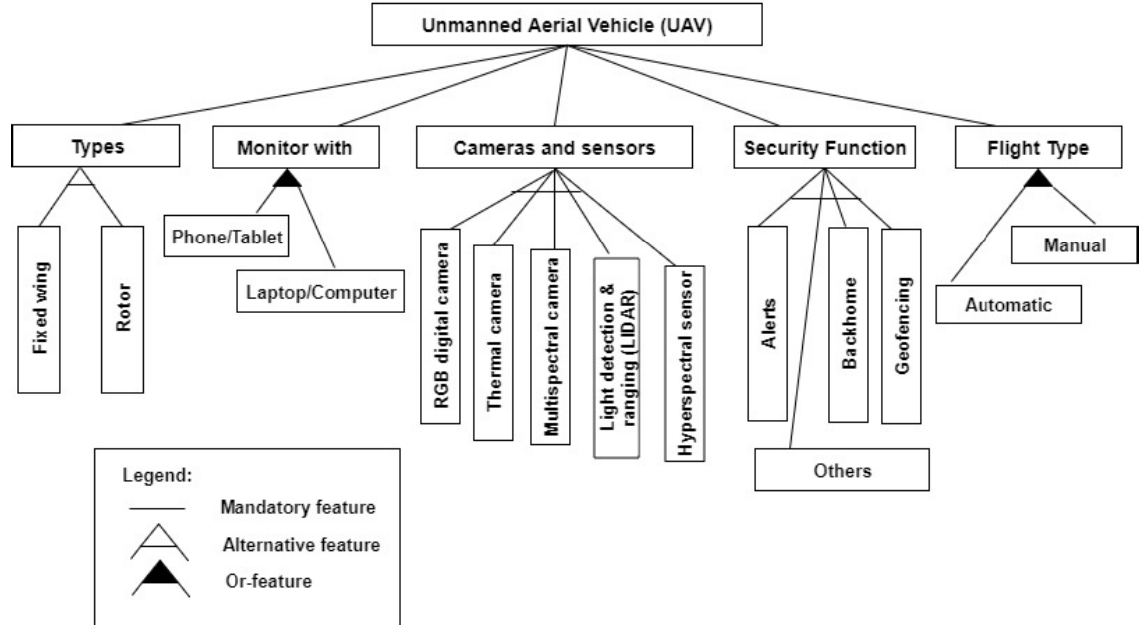
Figure 2. Feature diagram for Unmanned Aerial Vehicle (drone).